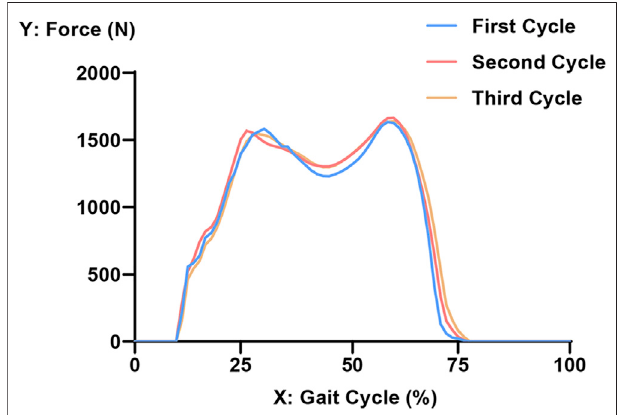
FIGURE 3 | Longitudinal compression force of the right knee during three gait cycles. The x-axis refers to the process of an entire gait cycle. A valueof0ontheY-axisrepresentsthesegmentwhereonlytheleftfootmakes contact with the ground. Furthermore, 10% ofthe gait cycle refers to the initial contact moment of the right heel, and 75% of the gait cycle refers to the right toe-off moment. The peak force is at about 60% of the gait